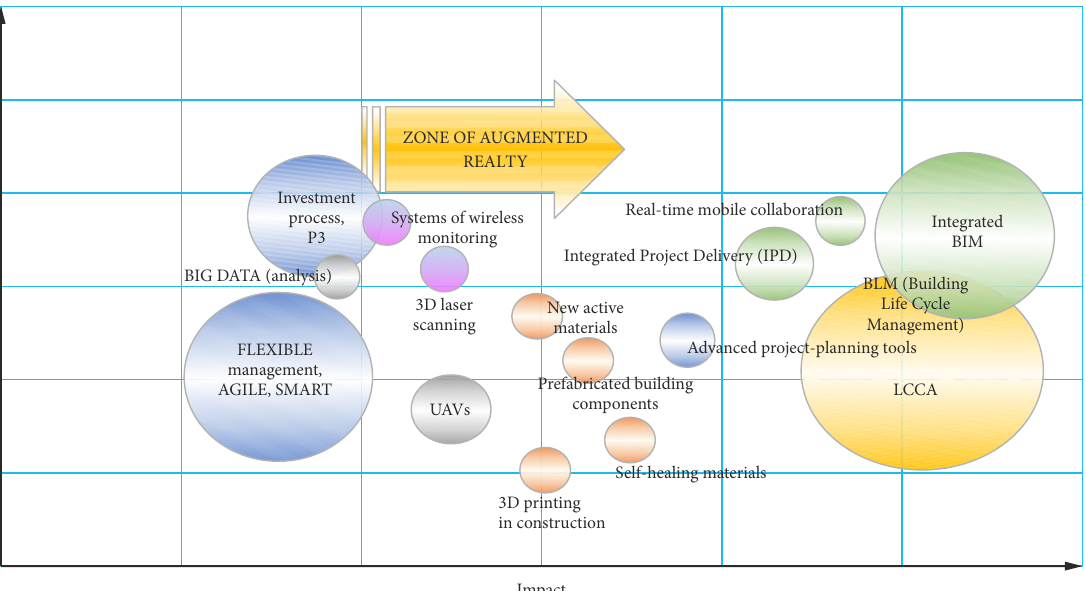
Figure 3. An attempt to identify rank and importance of new technologies in Construction Management – in the impact-likelihood setting